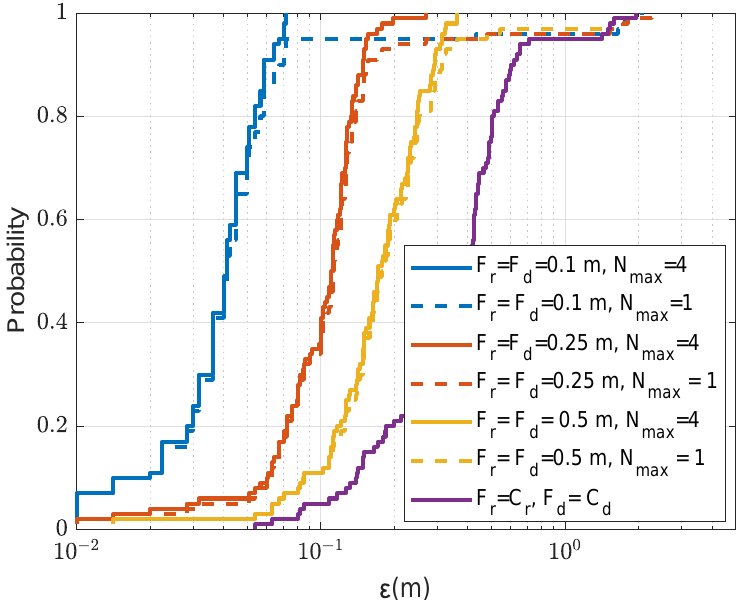
Figure 14. CDF for the localization error ε in the acoustic environment with the uniform SSP against the refinement step and multiple refinement areas, where only one point is removed after finding the next coarse AF maximum; N T = 4, the refinement area is 2 m × 2 m as shown in Figure